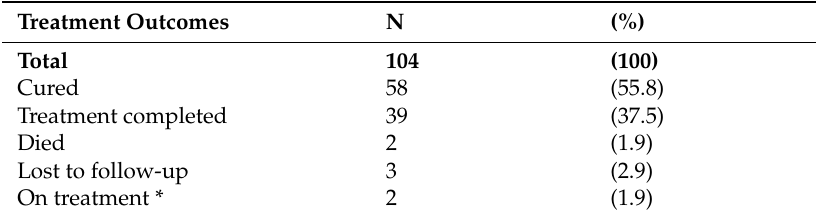
Table 4. Treatment outcomes among tuberculosis patients started on treatment in Haiphong International General Hospital in Vietnam, from June to December